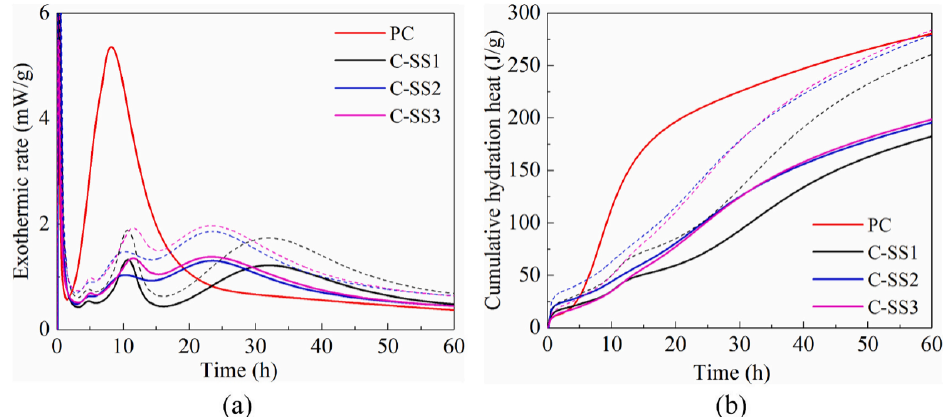
Figure 3. Effect of SS on the hydration heat of composite paste [75]. ( a ) Heat flow; ( b ) cumulative heat.